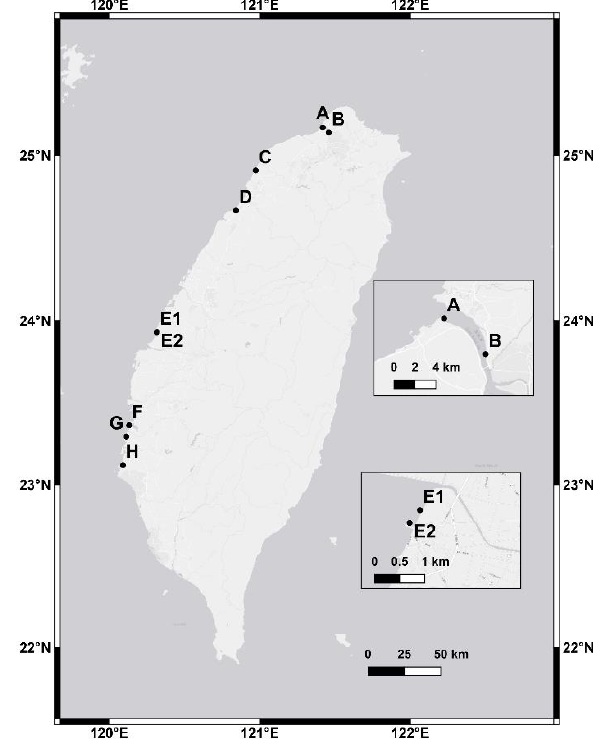
Figure 1. Location of the research sites: A — Wazihwei (WZ); B — Zhuwei (ZW); C — Xinfeng (XF); D — Zhunan (ZN); E1 — Fangyuan Kandelia obovata (FY-K); E2 — Fangyuan Avicennia marina (FY-A); F — Budai (BD); G — Beimen (BM); H — Chiku (CK) in Taiwan (map sources: QGIS 2.18.14). Table 1. Climatic conditions, mangrove characteristics and soil texture at the mangrove sites: A — Wazihwei (WZ); B — Zhuwei (ZW); C — Xinfeng (XF); D — Zhunan (ZN); E1 — Fangyuan Kandelia obovata (FY-K); E2 — Fangyuan Avicennia marina